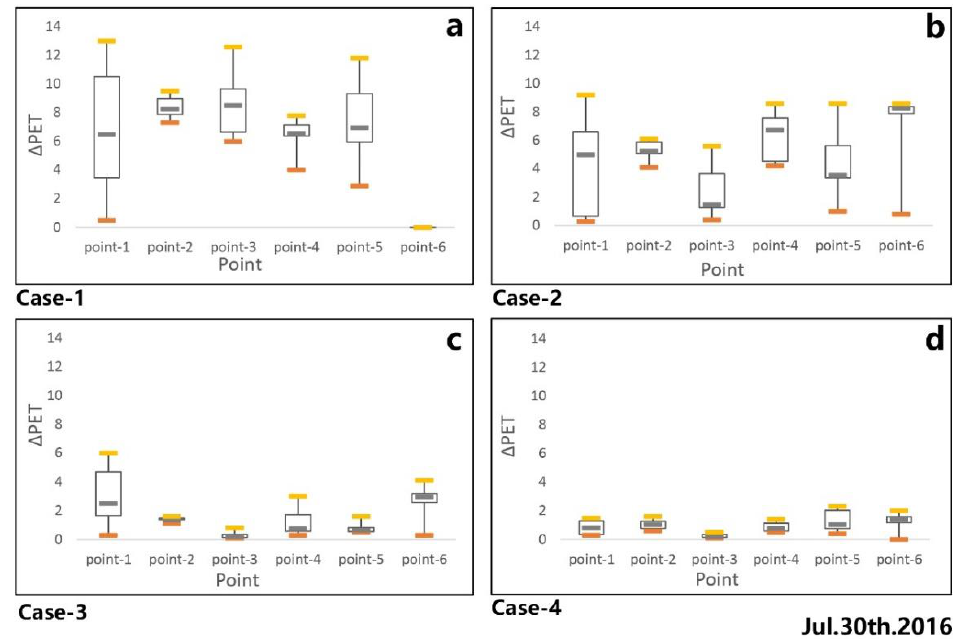
Figure 16. Cooling effect under the new cases at 3:00 pm. ( a ): case-1; ( b ):case-2; ( c ):case-3; ( d ):case-4.